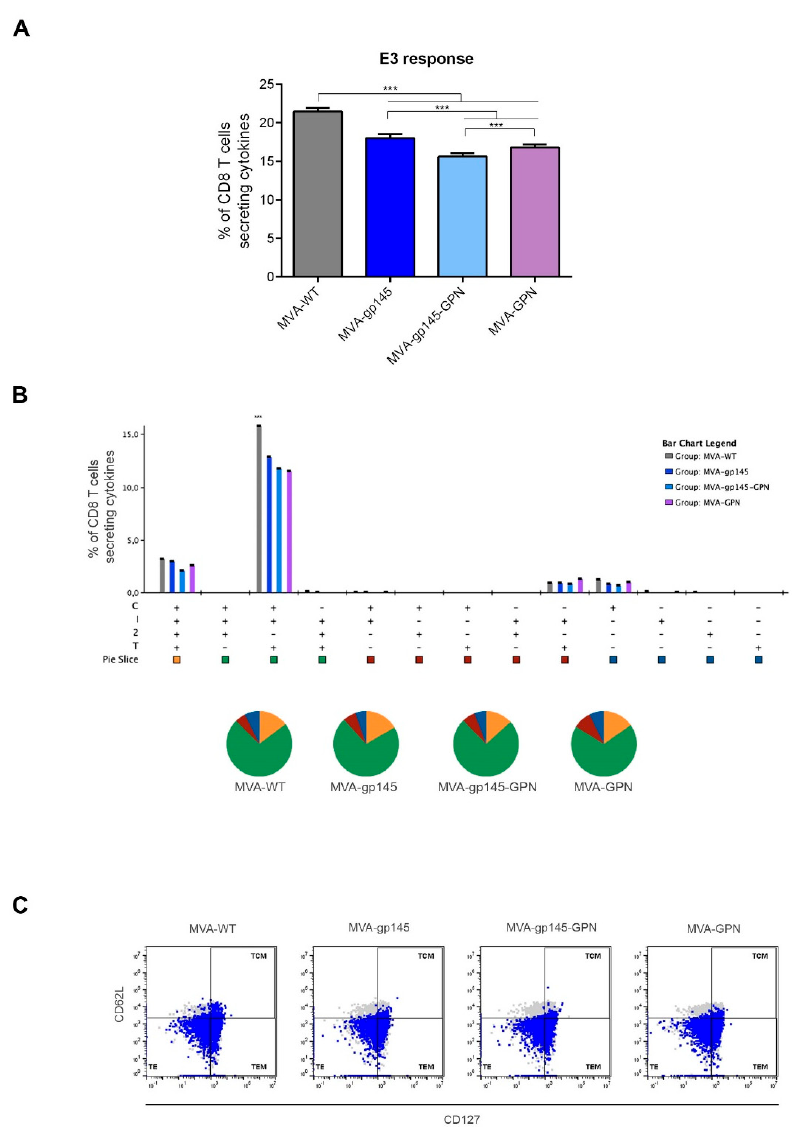
Figure 7. Polyfunctional VACV E3-specific CD8 T cell immune response elicited in the spleen after prime/boost homologous immunization of mice with different MVA-based recombinant viruses expressing gp145 and/or GPN antigens. ( A ) Magnitude of the VACV E3-specific CD8 T cells at 10 days post-boost by ICS assay after the stimulation of splenocytes with the VACV E3 peptide. The total value of each group represents the sum of the percentages of HIV-1-specific CD8 T cells secreting CD107a and/or IFN- γ and/or IL-2 and/or TNF- α against VACV E3 peptide. Data are background-subtracted. ***, p < 0.001. ( B ) Polyfunctional profile of the E3-specific CD8 T cell response in the different immunization groups. Distinct response combinations are indicated on the x axis, while the percentages of the functionally different cell populations within the total CD8 T cells are represented on the y axis. Specific responses are grouped and colour-coded based on the number of functions. C: CD107a; I: IFN- α ; 2: IL-2; T: TNF- α . ***, p < 0.001. ( C ) Flow cytometry profiles of the vaccine-induced memory CD8 T cell phenotype against VACV E3 peptide in the indicated immunization